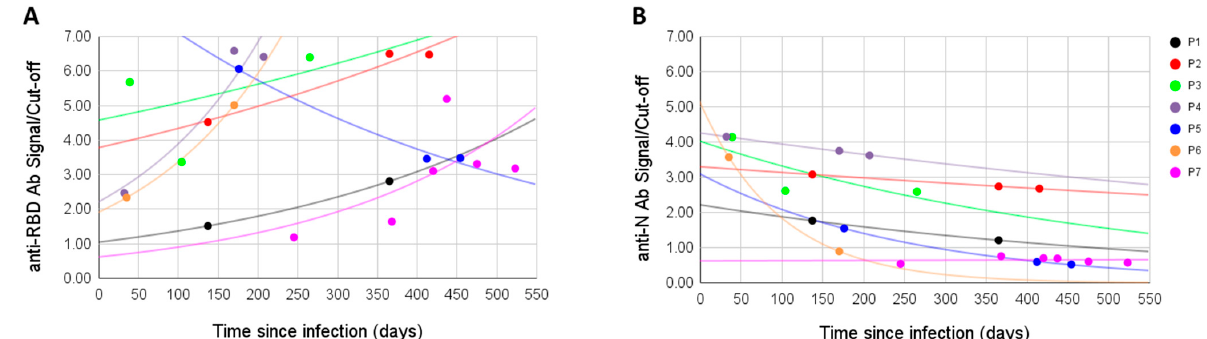
Figure 2. Antibodies to the RBD antigen ( A ) and to the N antigen ( B ) measured at different time points for seven patients (P1–P7).